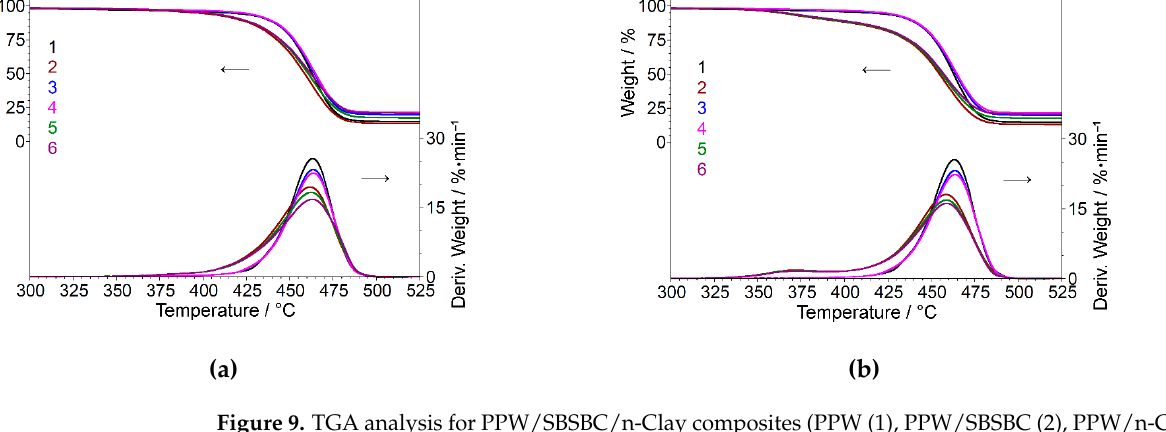
Table 6. Thermal parameters evaluated from TGA curves.